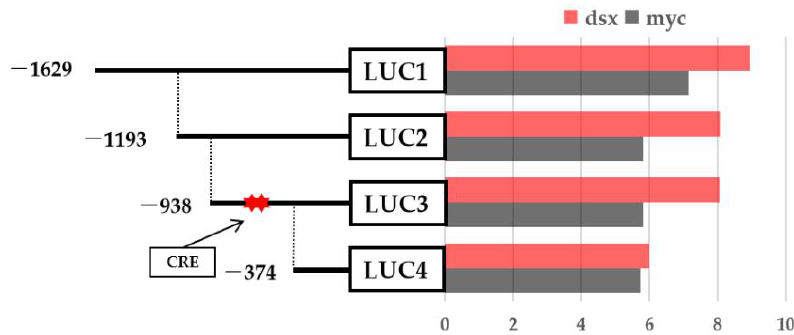
Figure 9. Effects of PmDsx overexpression on the activity of different 5 ’ flanking regions of the IAG promoter in P. monodon . The red pentagram represents the binding site of PmDsx in the PmIAG promoter region. The data represent the means ± SE ( n = 3). The different symbols above the error bars in the figure indicate statistical differences at p < 0.05, as determined by one-way ANOVA fol- lowed by the post hoc test compared with the control.